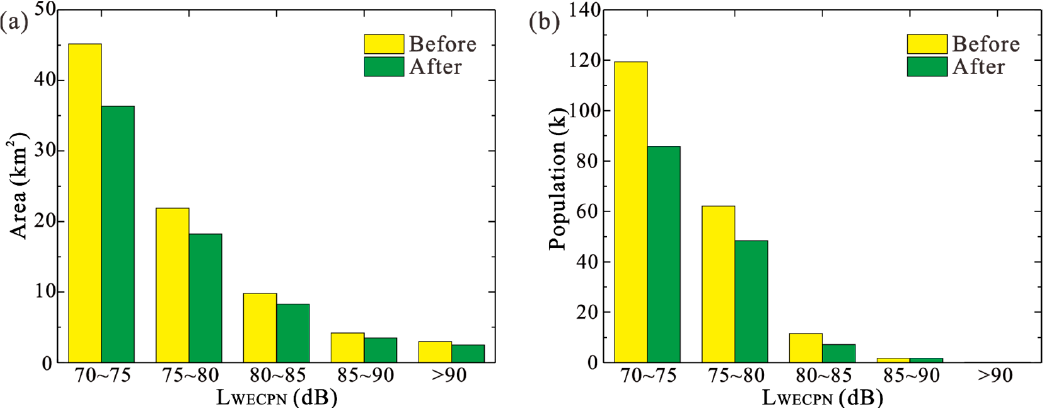
Figure 4. Noise reduction effects before and after using the low-noise aircraft type during summer: ( a ) area; ( b ) population.